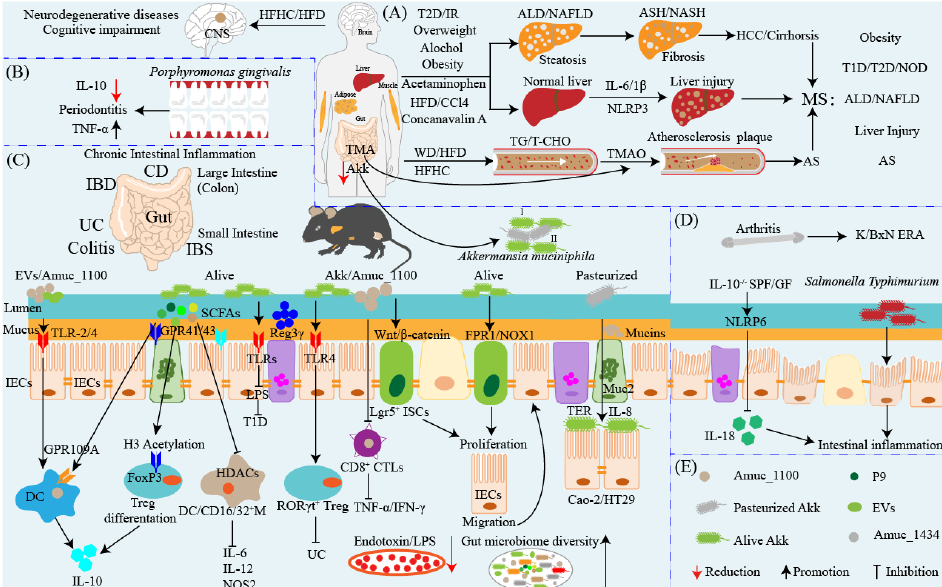
Figure 2. The duality and challenge of Akkermansia muciniphila in metabolic syndrome and inflam- mation therapy. Metabolic syndromes include ALD, NAFLD, NASH, neurodegenerative diseases induced by diets such as HFD/HFHC, and atherosclerosis, and have become one of the major chal- lenges of diseases affecting global public health. Akk as the next promising candidate probiotic shows outstanding antimetabolic syndrome potential. ( A ) Long-term HFD/HFHC diets usually result in neurodegenerative diseases such as cognitive impairment, impaired spatial working memory and novel object recognition, and damaged brain metabolism in early life, while supplementation with Akk can prevent it. T2D, overweightness, obesity, and long-term alcohol consumption generally accompanied by and/or leading to NAFLD/ALD, which include simple steatosis, fibrosis, and cir- rhosis, all of which can deteriorate towards ASH/NASH and ultimately deteriorate to HCC. Dietary supplement of Akk ameliorates NAFLD/ALD via regulating lipid and glucose metabolism and intestinal microbiota and eventually improves body metabolic health. Furthermore, HFD usually induces chronic liver injury and inflammatory response, whereas supplementation with Akk saves it by regulating lipid metabolism and inhibiting inflammation. AS is the main contributor to cardiovas- cular mortality, which is mainly induced by TG/T-CHO, excessive accumulation in WD/HFD/HFHC diets and results in narrowed or blocked blood vessels that drive the cardiovascular events that occur. TMA, one of the metabolites of choline, is metabolized by the gut microbiota to produce TMAO that is proatherogenic and accelerates PROGRESSION, whereas Akk regulates lipid metabolism and inflammatory response to inhibit AS. ( B , C ) The anti-inflammation and proinflammatory function of Akk in the gut and other organs. ( B ) Akk ameliorates porphyromonas-gingivalis -induced periodontitis by inhibiting bone destruction and TNF- α proinflammatory cytokine secretion and upregulating IL-10 production. ( C ) Akk improves chronic and acute intestinal inflammation including IBD,